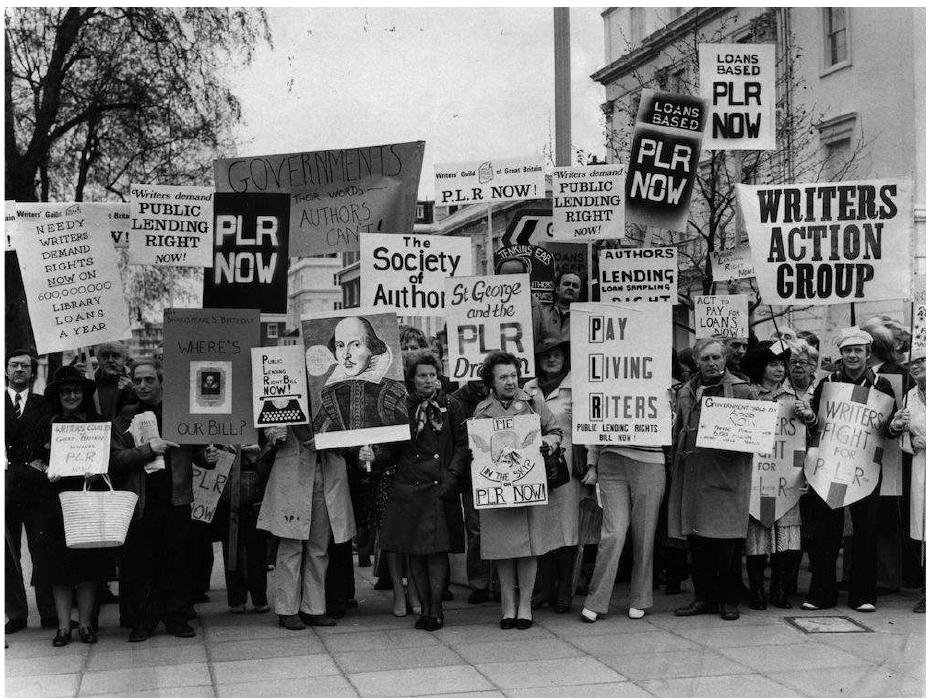
Figure 1: Campaigning by the Writer’s Action Group (c.